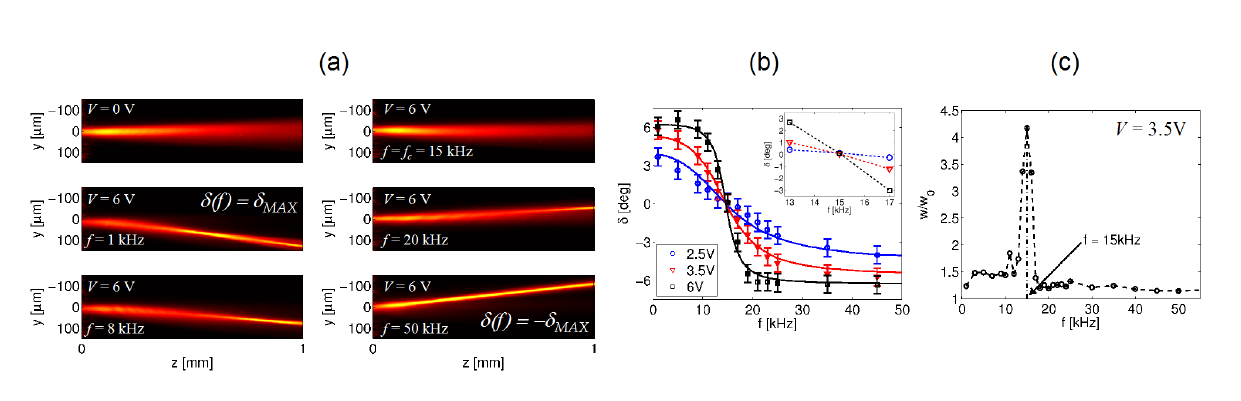
Figure 13. ( a ) Photographs of frequency-controlled nematicon steering; ( b ) Walk-off versus bias frequency for various rms (root mean square) voltage values. The lines